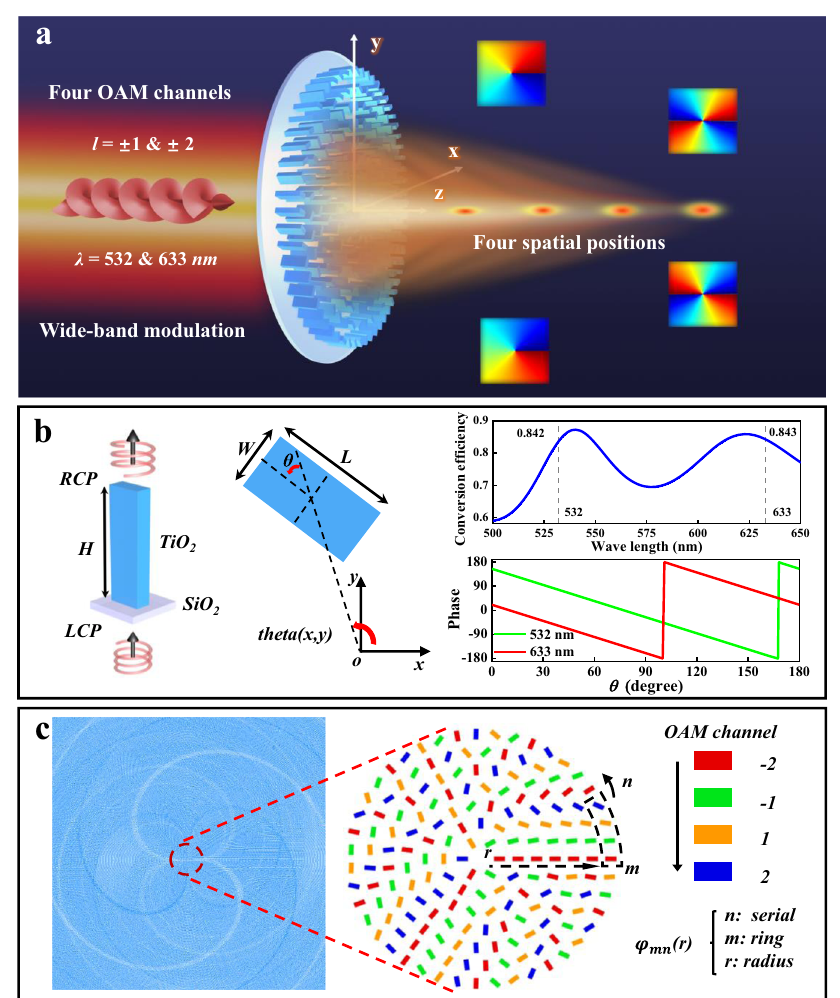
Fig. 1 | Function diagram and design principle of the VDM. a Schematic of the con fi guration and the functions with multiband varifocal of the VDM. b The left is the unit cell diagram and layout schematic, and the middle displays the relative positions between the center of the circle and rotation angle of the unit nano fi n, where the coordinate axismeans the center of the circle and the θ isthe clockwise